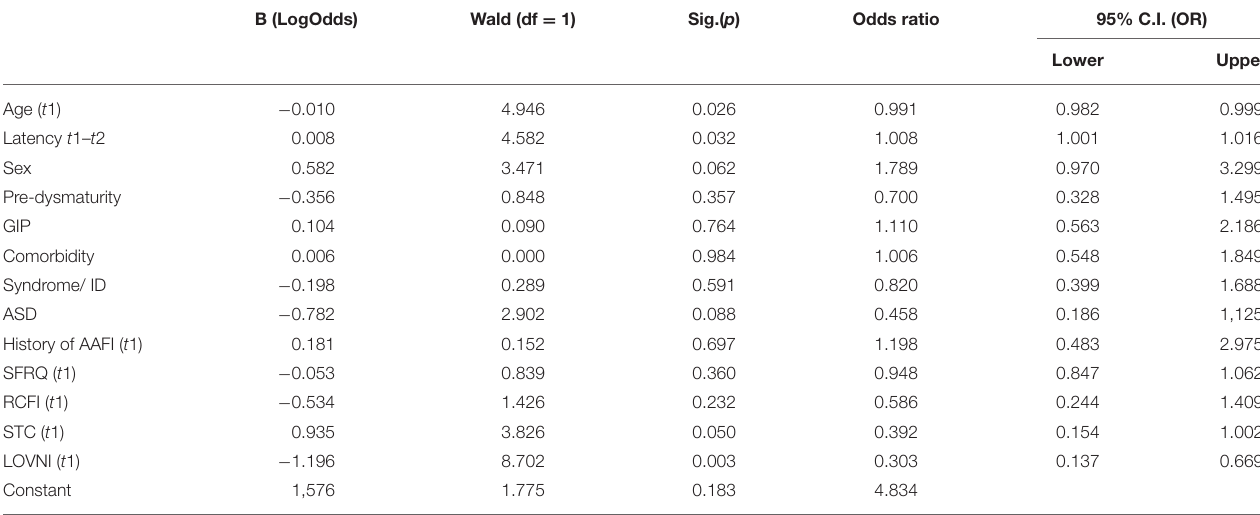
TABLE 4 | Logistic regression model of all t 1 variables in the equation.